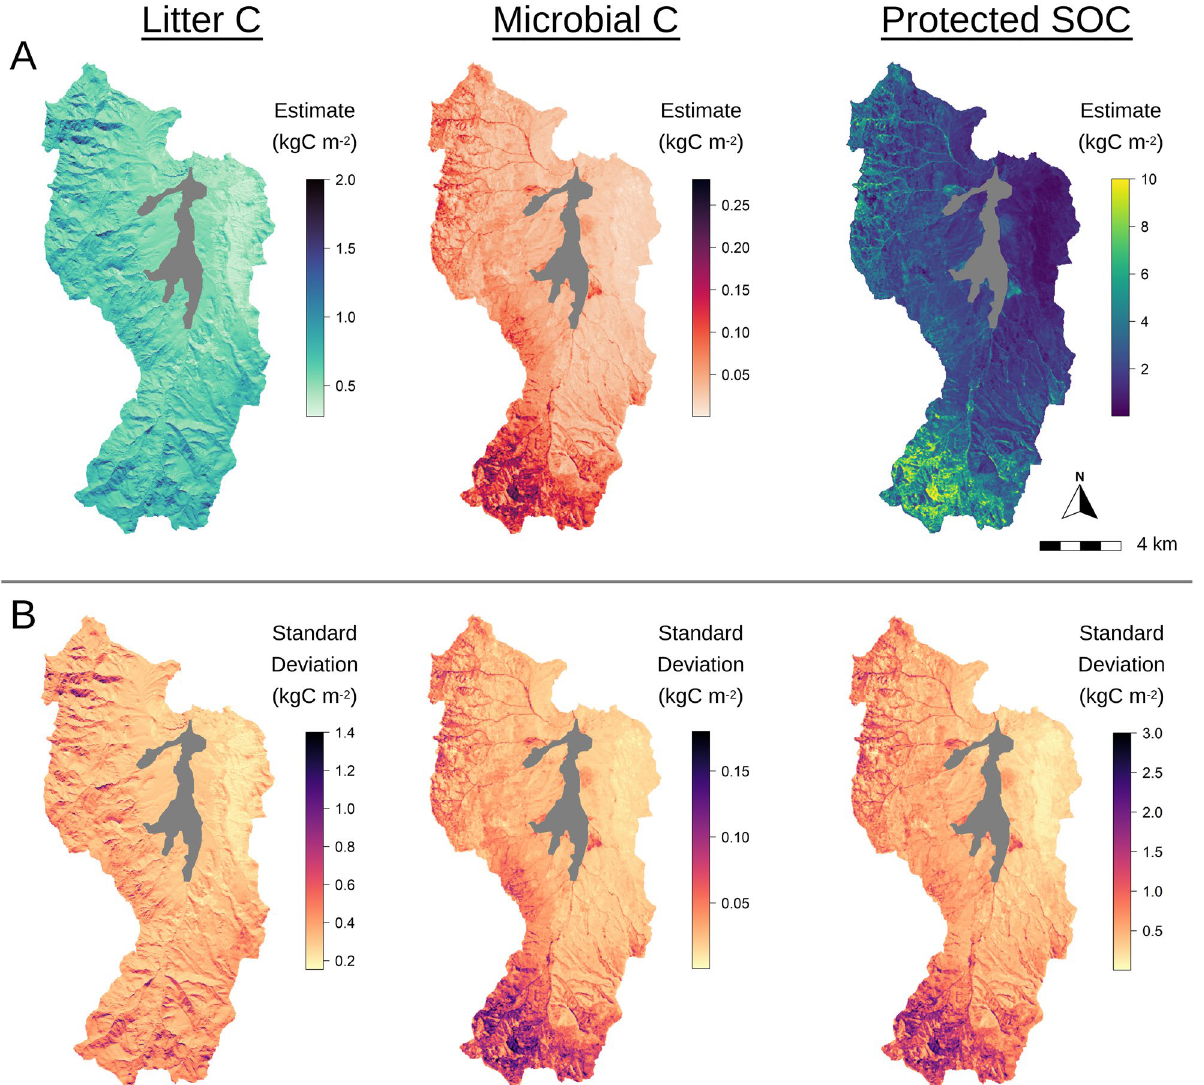
Figure 6. Ensemble ( A ) mean and ( B ) standard deviation of soil carbon pool stocks for 0–30 cm soil depth across the natural area of the Reynolds Creek Experimental Watershed and Critical Zone Observatory (n = 30 maps of soil C generated by the parameter ensemble produced from model calibration with site observations; Fig. 3a). (Generated by free software R, https:// www.R- proje ct.